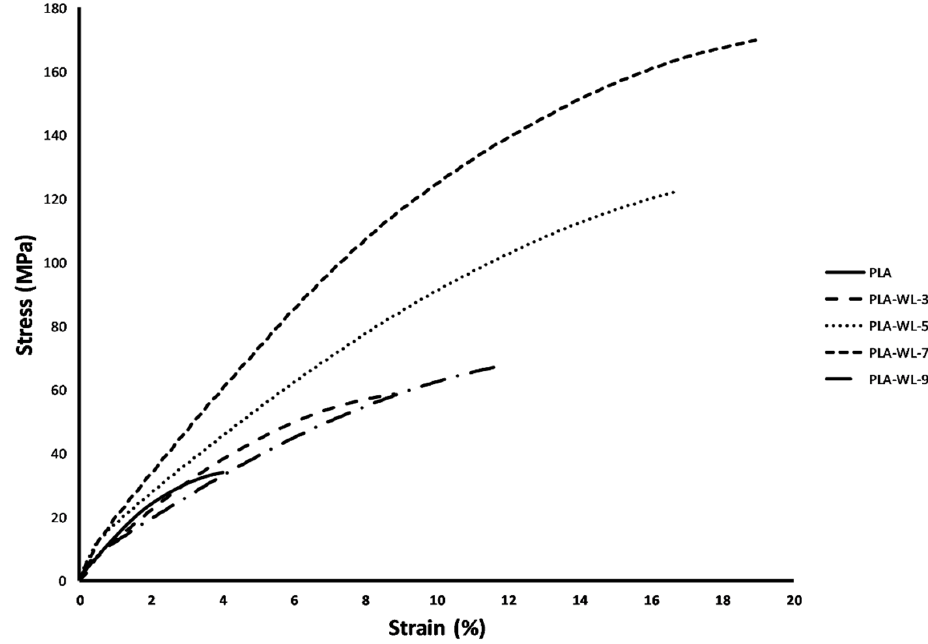
Figure 3. Stress–strain curves of tensile tests for neat PLA and PLA ‐ WL biocomposites.